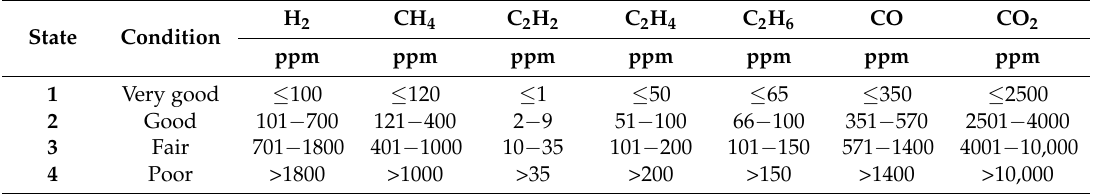
Table 1. Recommended condition parameter data limit and condition for dissolved gases.